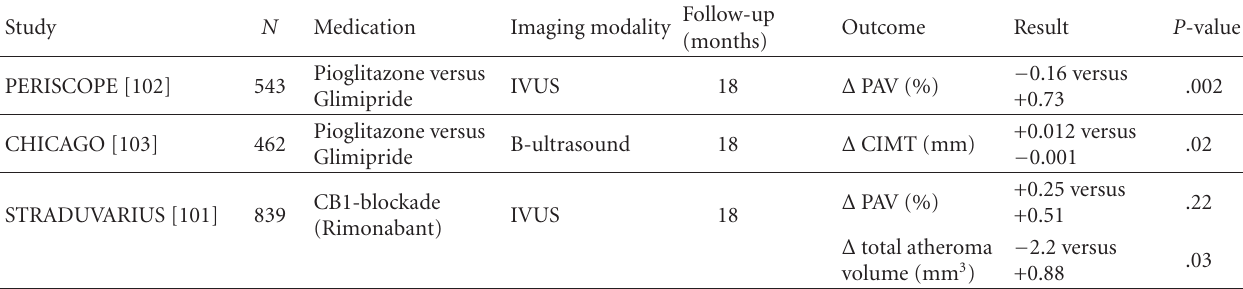
Table 4: Summary of trials highlighting the e ff ects of oral hypoglycemic agents and CB1 receptor blockade on atherosclerosis. progression. Follow-up Study N Medication Imaging modality Outcome Result P -value (months) Pioglitazone versus PERISCOPE [102] 543 IVUS .002 Glimipride +0.73 Pioglitazone versus CHICAGO [103] 462 Glimipride